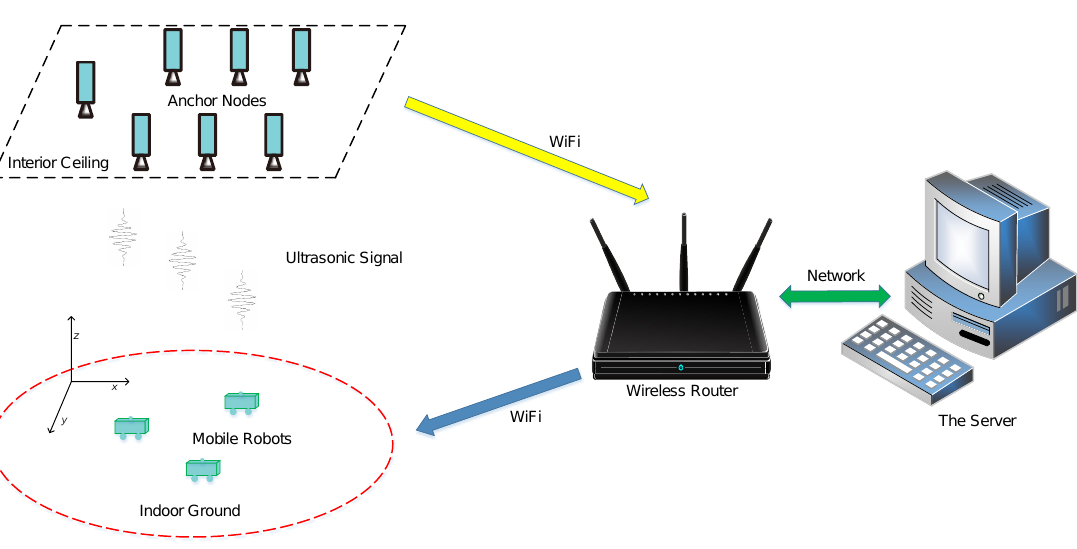
Figure 1. The architecture of the ultrasonic indoor positioning system (UIPS).